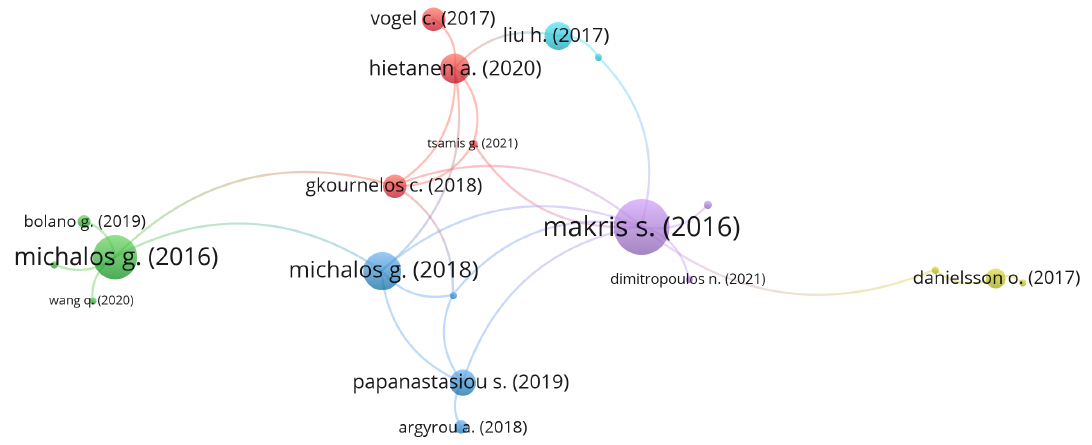
Figure 11. Document citation correlation between the selected papers.